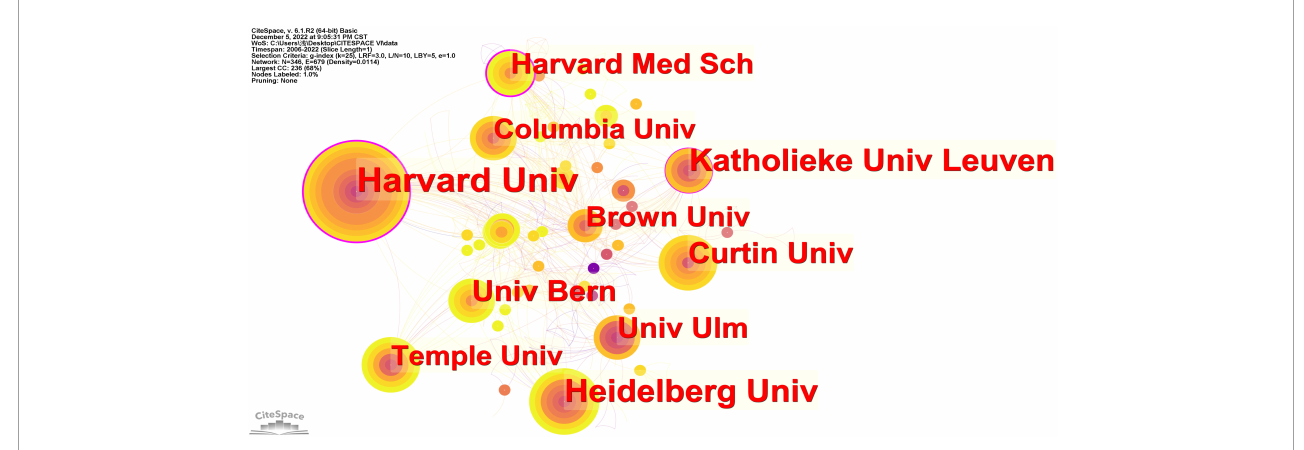
FIGURE3 An institution cooperation map related to non-suicidal self-injury (NSSI) research by CiteSpace. The larger circle is, the more publications output of institution is; the links between nodes showed the network of cooperation, the denser the link, the more cooperation of institution